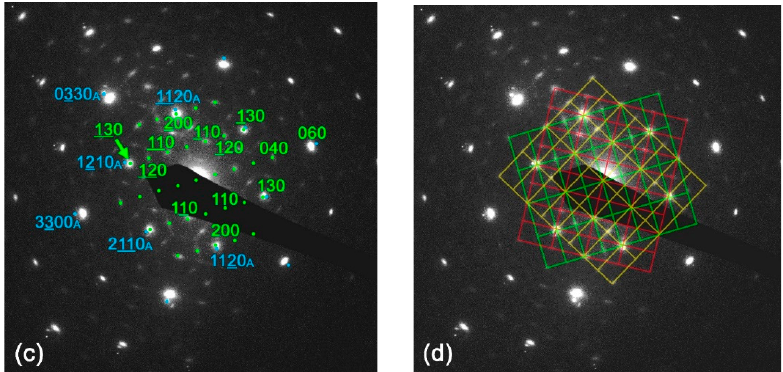
Figure 3. ( a ) Plan-view SAED pattern taken from a thin part of specimen without the substrate contribution. ( b ) SAED pattern from a thicker part of specimen shows possible indexing using pure ε -phase presence. The indices A and ε correspond to Al 2 O 3 and Ga 2 O 3 diffractions, respectively. ( c ) The green indices correspond to one possible domain orientation of the κ -phase. ( d ) The schema shows how the presence of the κ - phase domains rotated by 60° and 120° can explain all diffraction spots of the pattern.